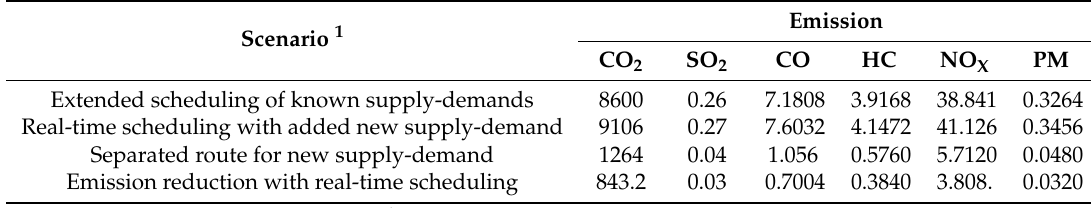
Table 11. Calculated GHG emission in the case of lignite-based electricity generation.